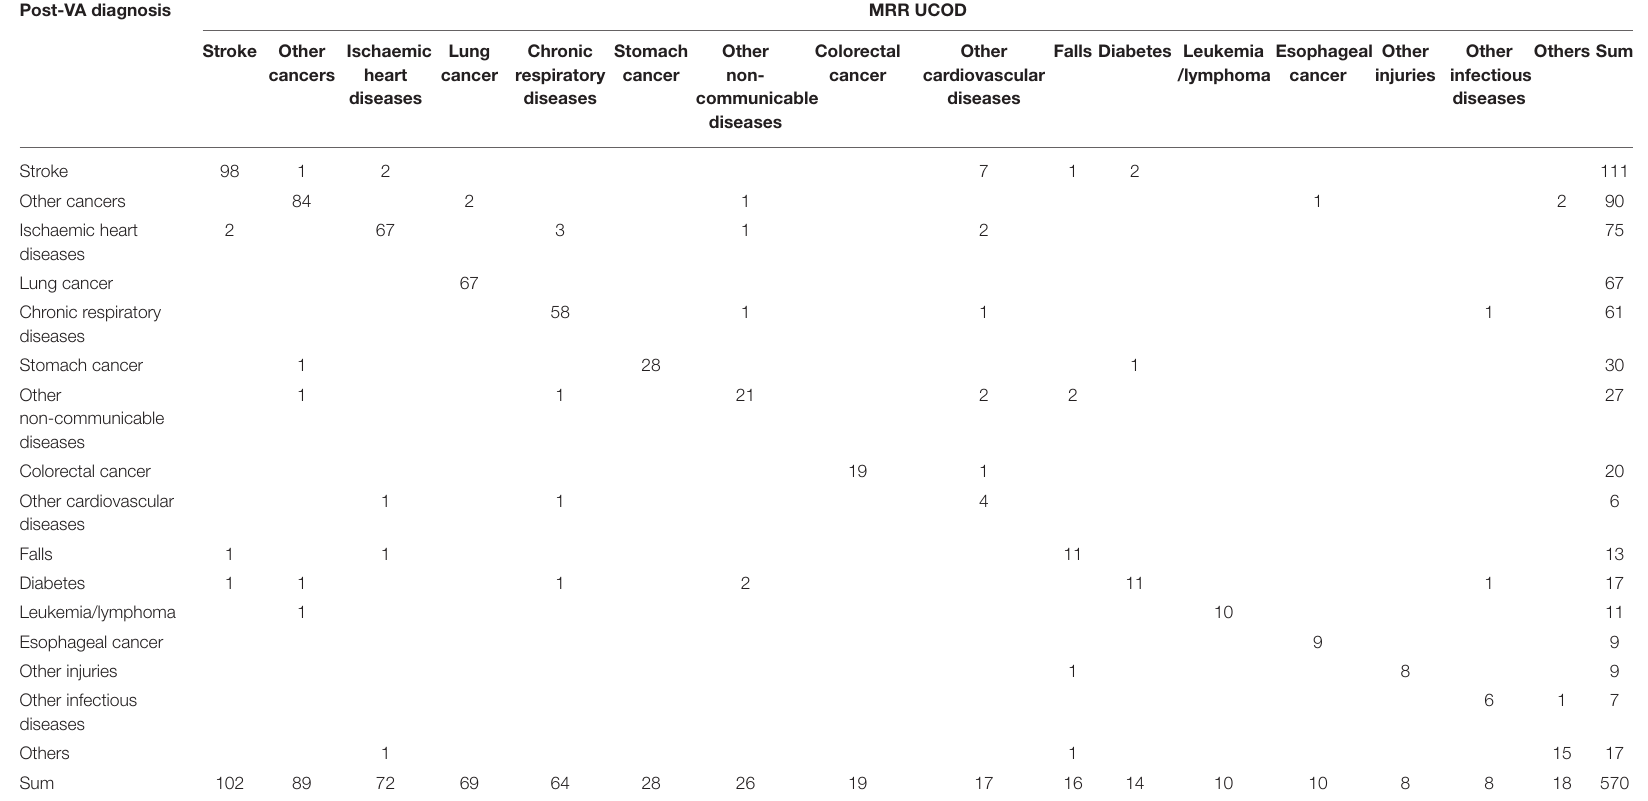
TABLE 5 | The concordance between post-VA diagnosis and MRR results. Post-VA